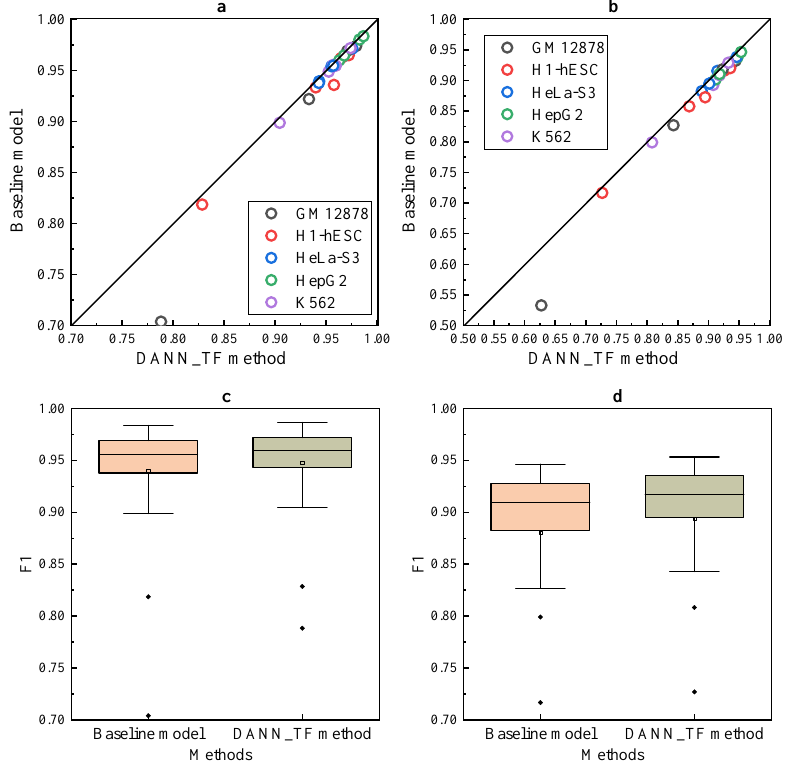
Figure 3. Performance for cross-cell-type prediction. Scatter plot depicting ( a ) AUC and ( b ) F1 score of DANN_TF and the baseline method. Box plots depicting ( c ) AUC and ( d ) F1 score of DANN_TF and the baseline